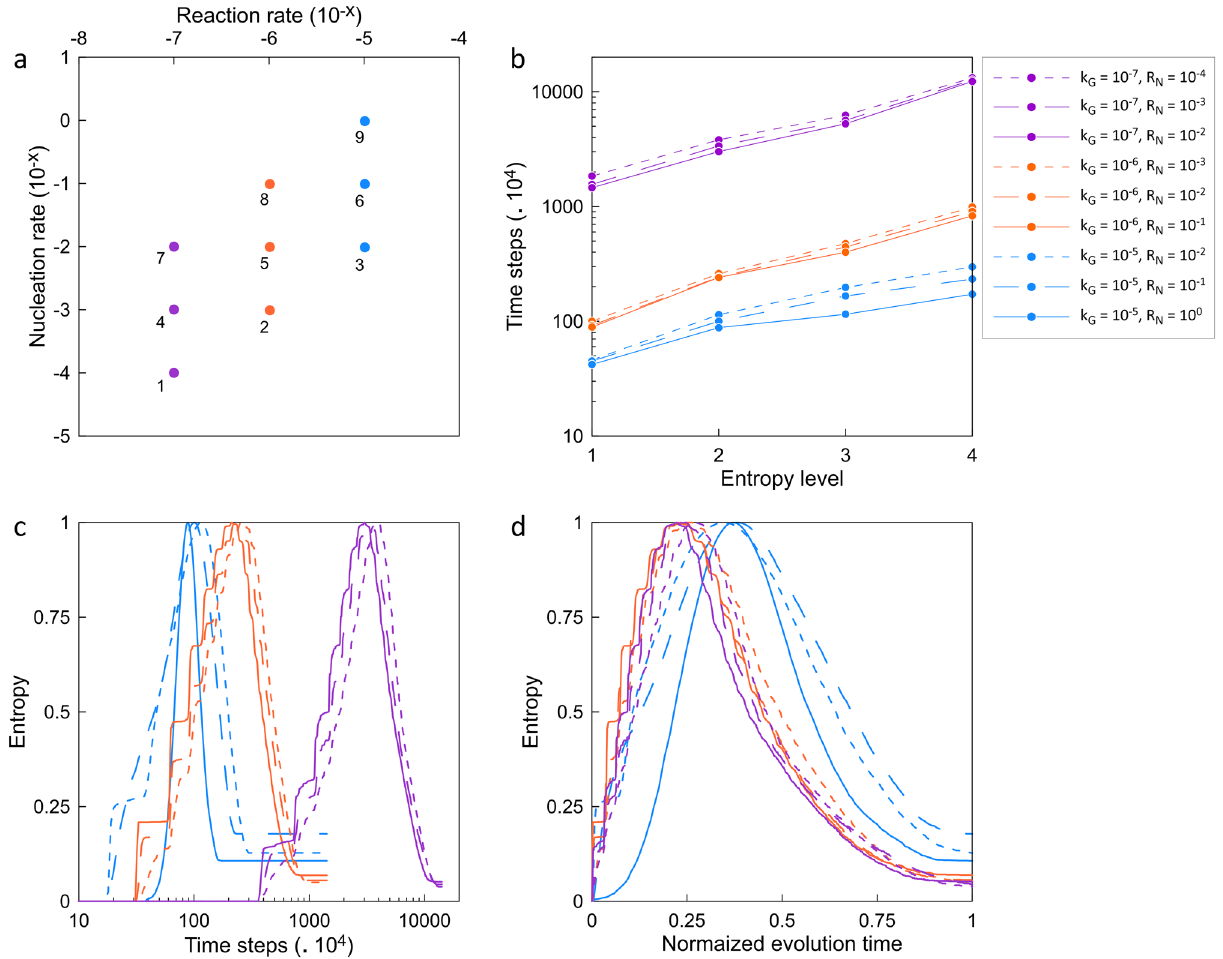
Figure 4. Analysis of Lattice Boltzmann Method (LBM) simulation results with probabilistic nucleation model at different physiochemical conditions. ( a ) Overview of reaction rates constant (k G ) and nucleation rate (R N ) for simulation scenarios; ( b ) simulation time (× 10 4 ) versus entropy levels for precipitation maps in Fig. 3; ( c ) computed Shannon entropy during simulation time (× 10 4 ) for subplots in Fig. 3 until solid accumulations entirely covers the substrate; and ( d ) computed Shannon entropy versus normalized evolution time, where the horizontal axis is the normalized simulation time with respect to the overall time span for each graph in part c. Scenarios with similar color represent similar reaction rates constant (k G ), and different line styles demonstrate different nucleation rates (R N ). At each k G , three orders of magnitude R N was